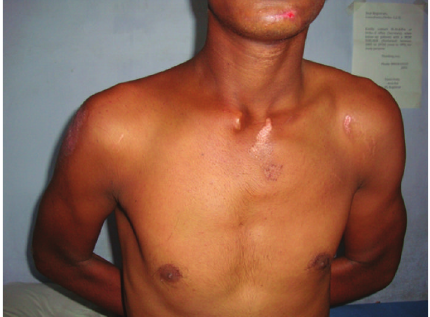
Figure 2: Clinical photograph showing cosmetic deformity but full internal rotation at 18-month follow-up.